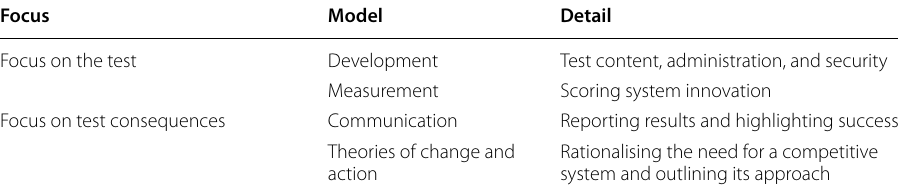
Table 1 Operationalising the socio-cognitive model (Chalhoub-Deville & O’Sullivan,